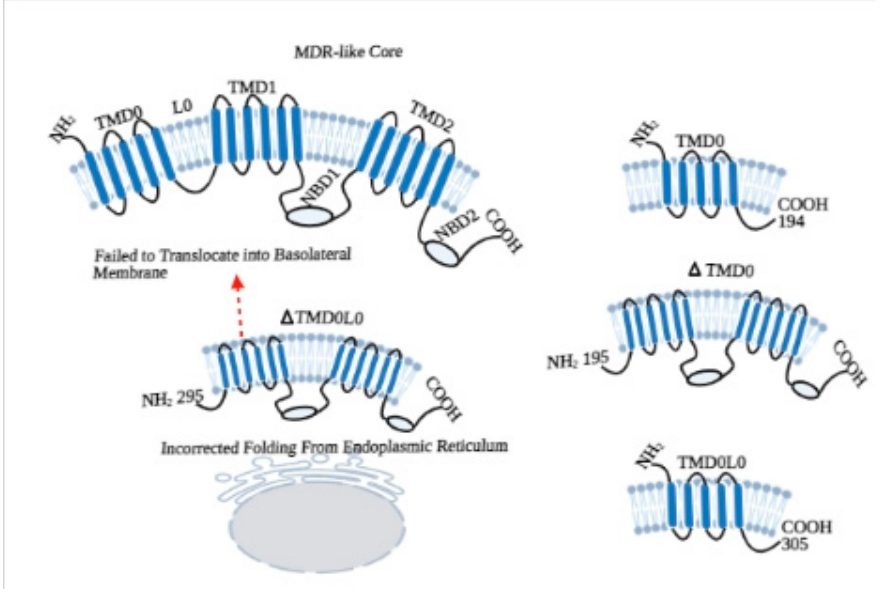
Figure 2. Topology of ABCC6 transporter [20].